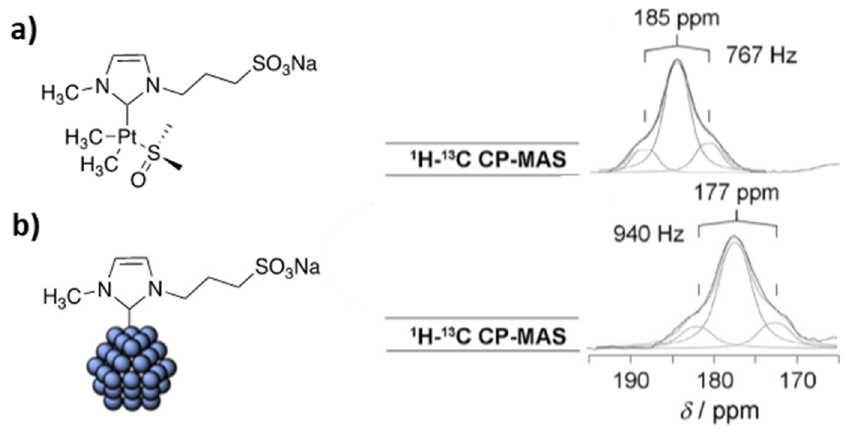
Figure 10. 13 C{ 1 H] CP MAS ‐ NMR spectra of ( a ) molecular Pt(II) complex and ( b ) NHC ‐ stabilized Pt NPs. Reproduced from reference 55 with permission of Wiley ‐ VCH.